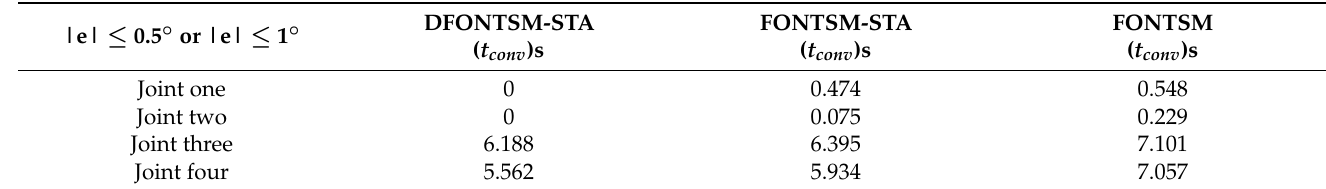
Figure 18. Terminal motion under base coordination system. ( a ): Terminal trajectory tracking curve; ( b ): initial part of the terminal trajectory tracking curve.